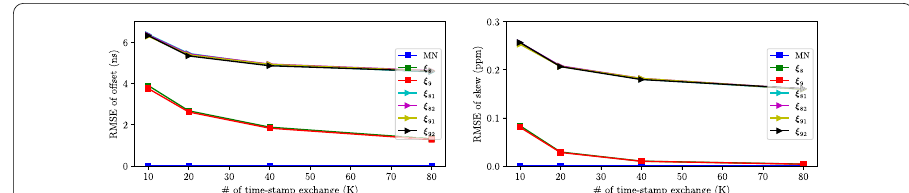
Fig. 11 Impact of number of time-stamp exchanges K